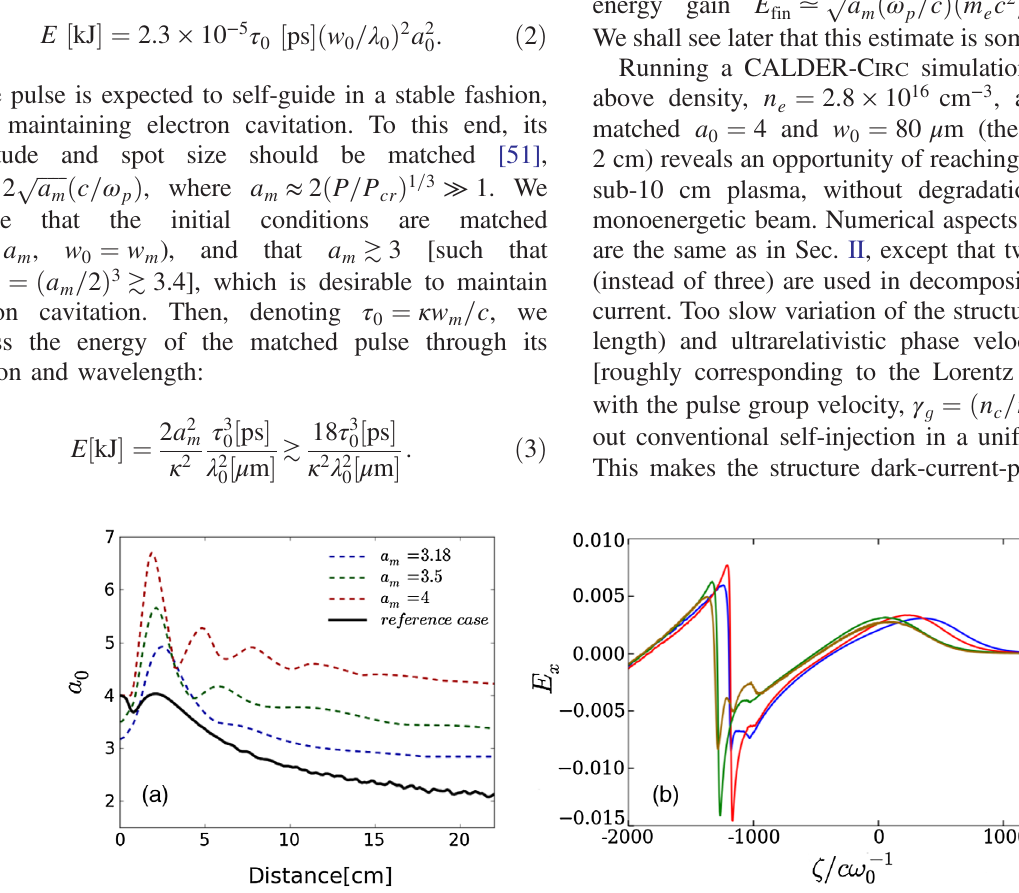
FIG. 4. Long-term pulse and wake evolution in the blowout regime. (a) WAKE simulation: evolution of the normalized peak vector potential of the pulse over 22 cm for the parameters used in the CALDER-C IRC simulation (the reference case: a 0 ¼ 4 , 2 . 8 × 10 16 cm − 3 — solid black line), and for matched parameters corresponding to a n e ¼ 4 . 4 × 10 16 cm − 3 (dashed green line) and a red line), a 0 ¼ 3 . 5 and n e ¼ c ω 0 =e ) on the propagation axis after 1.5 cm (blue), 4 cm (red), 6.5 cm (green) and 9 cm (gold) in (b) Accelerating field E (in units m x e the reference case (CALDER-C IRC